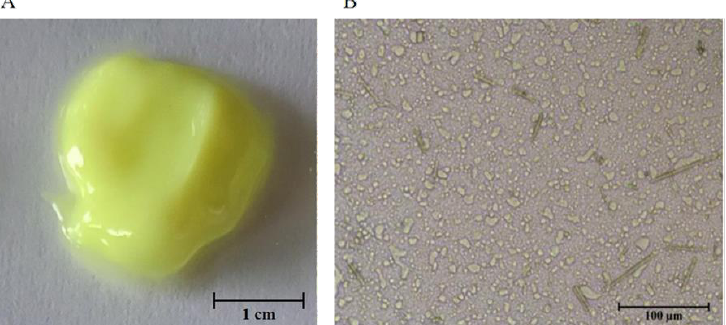
Figure 2. Appearance of optimized sample and its particle size under microscope. ( A ) The optimized cream showed as a uniform yellowish-green paste with lustrous, smooth surface, and was easy to spread. ( B ) The distribution of the water phase, oil phase, and CA crystal were uniform, and no crystal with a size larger than 180 μm was found in all samples.